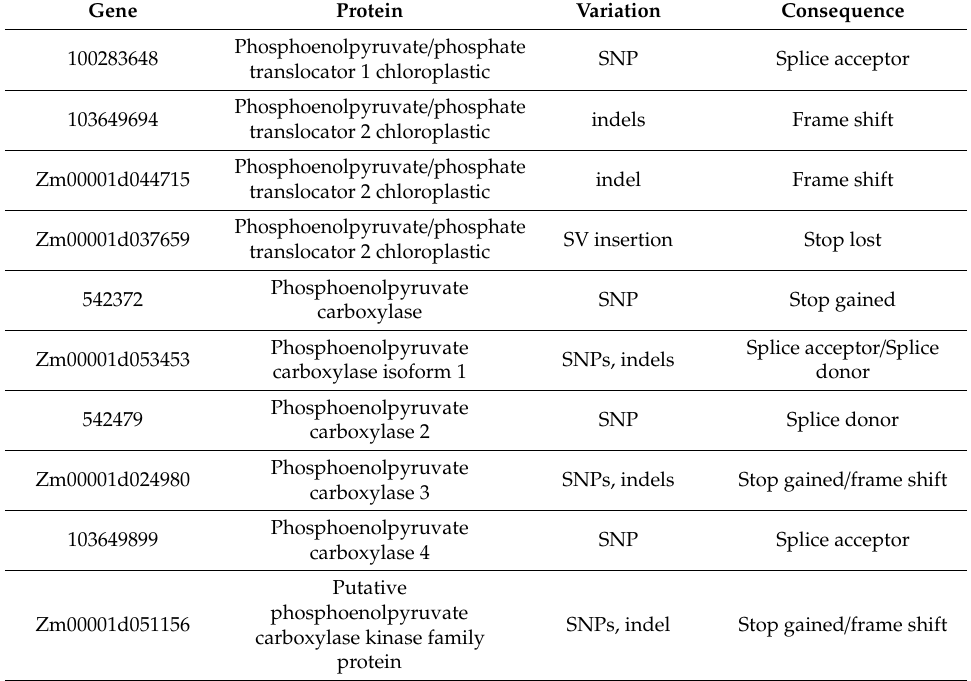
Table 5. Genes associated with phosphoenolpyruvate availability affected by genetic variations between tested lines.